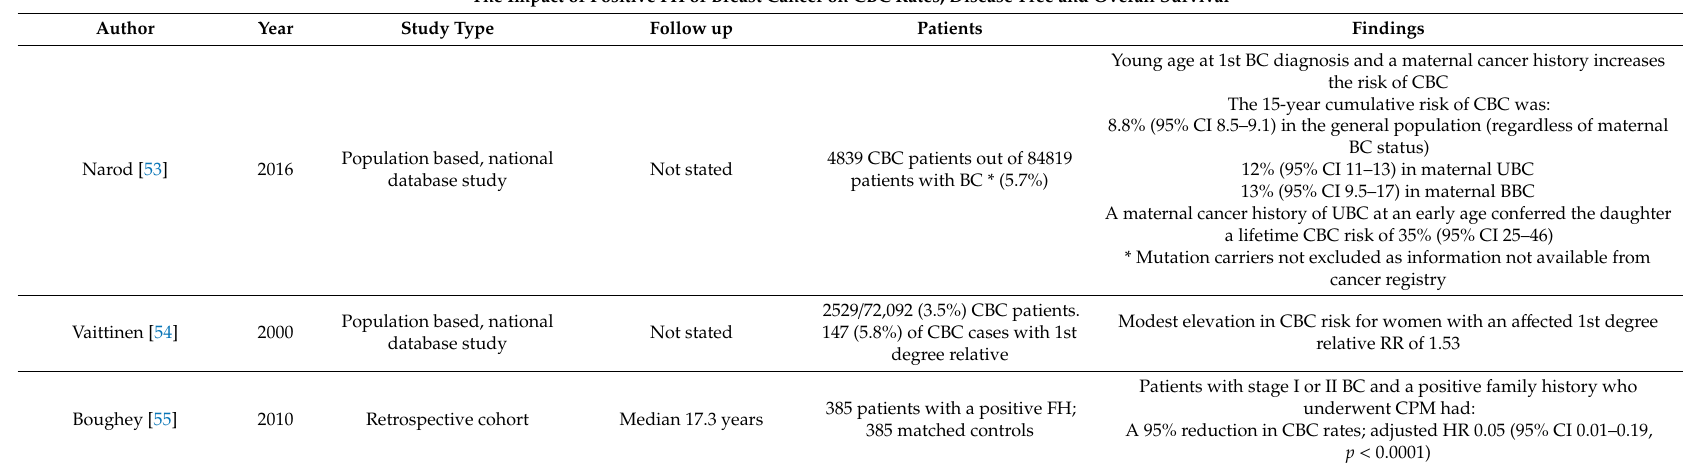
The Impact of Positive FH of Breast Cancer on CBC Rates, Disease-Free and Overall